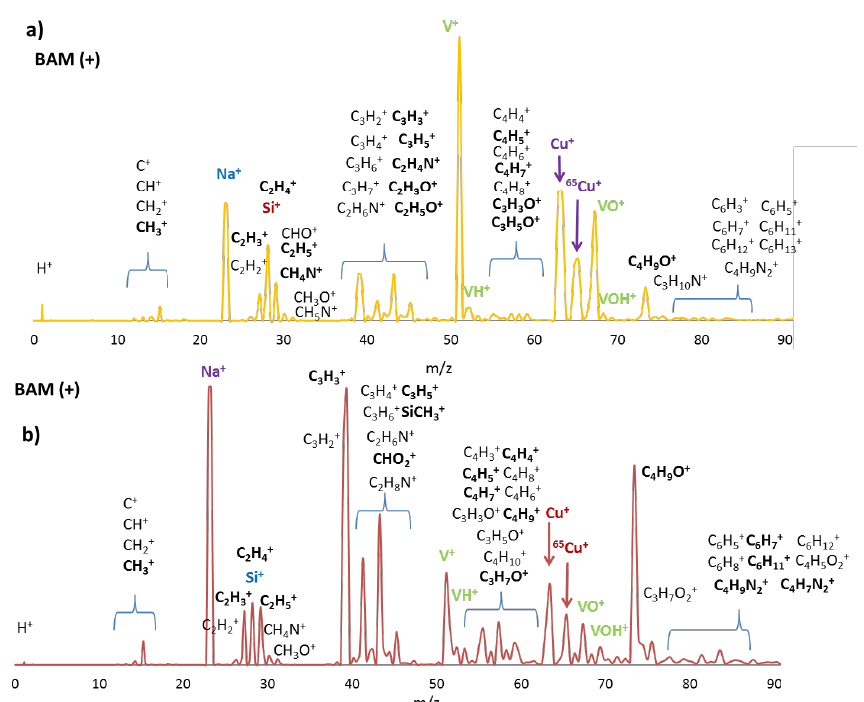
Figure 6. 30 KeV Bi + SIMS (+) spectrum recorded in BAM with assignment of the most probable fragments of the organic components and metals, highlighting the strongest signals for ( a ) BF1 and ( b ) BF2 .